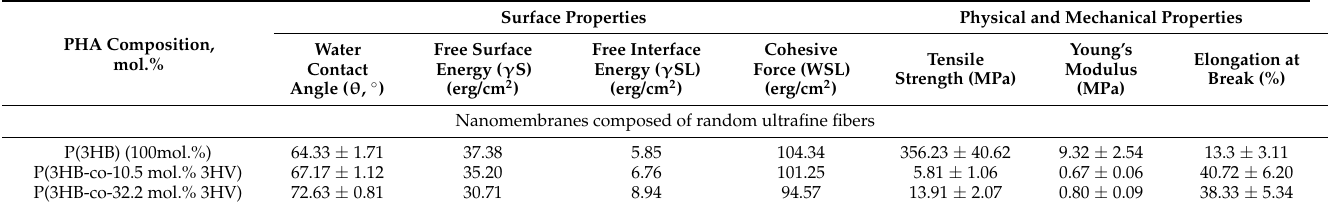
Table 3. Surface properties and physical and mechanical characteristics of nanomembranes obtained by electrospinning and PHA solutions of various compositions.